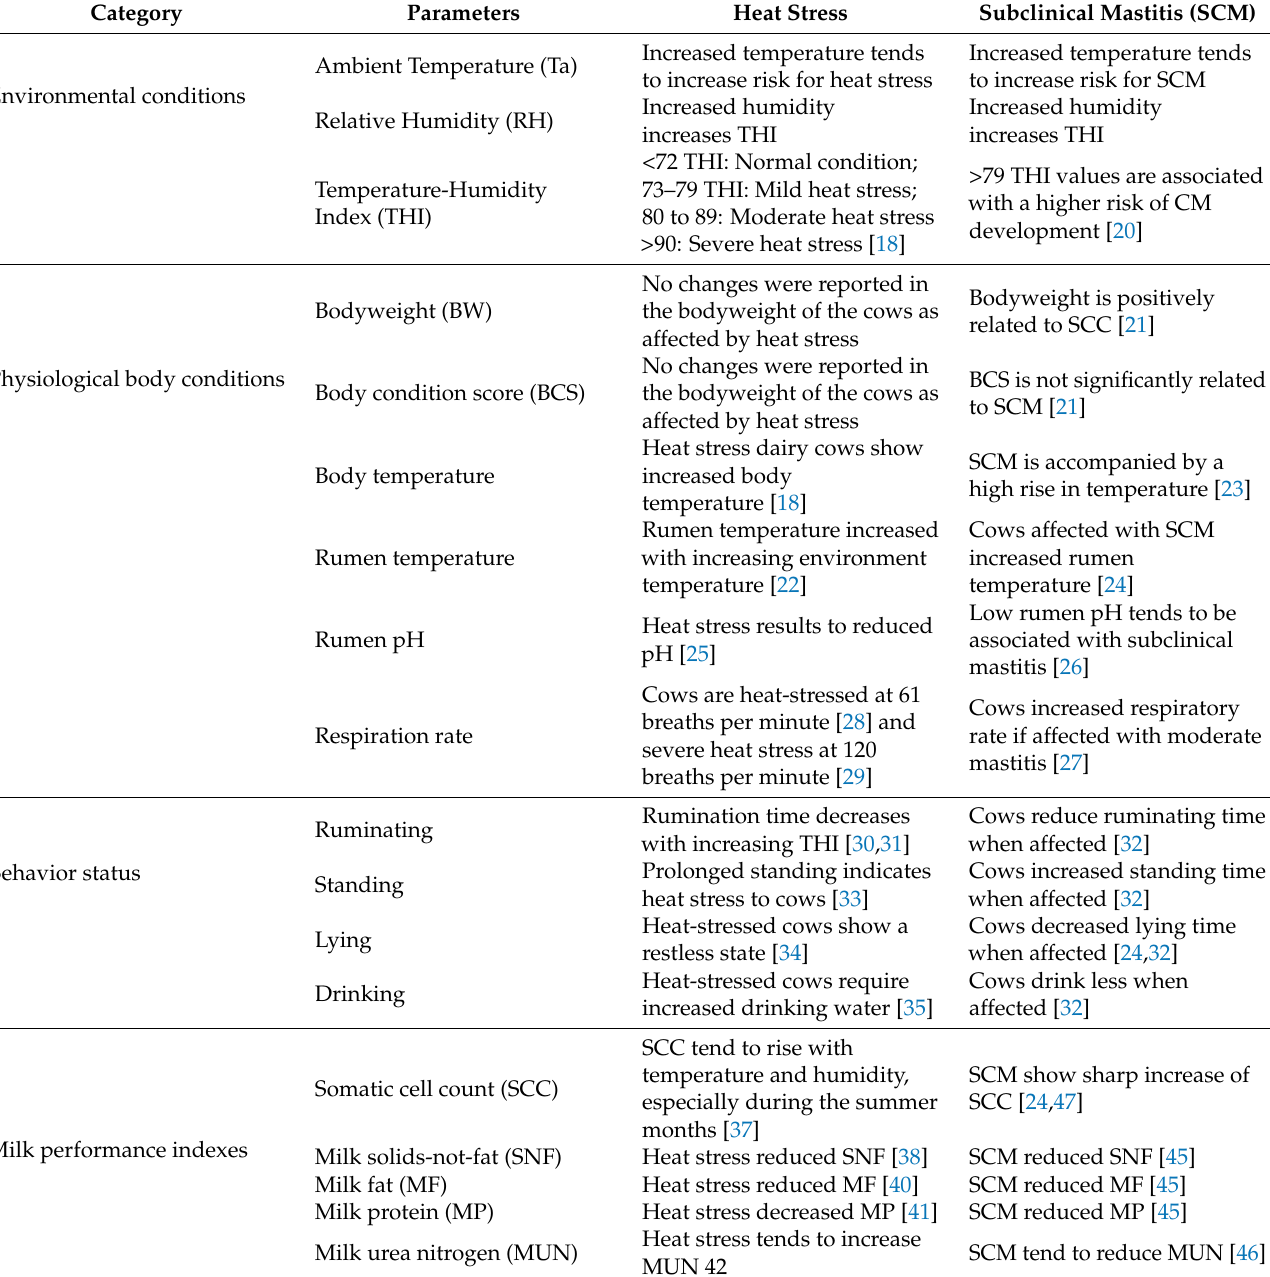
Table 1. Selected parameters that were used for detecting the status of the